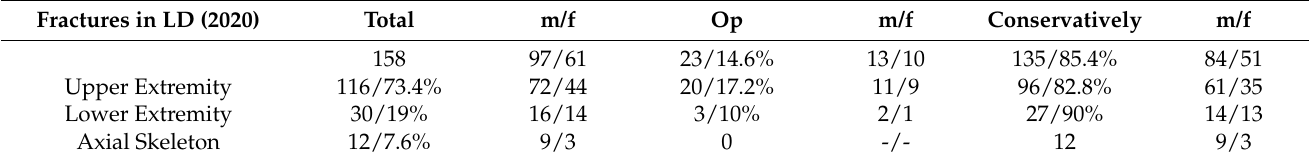
Table 3. Distribution of fractures according to region, sex, and treatment modality during LD.